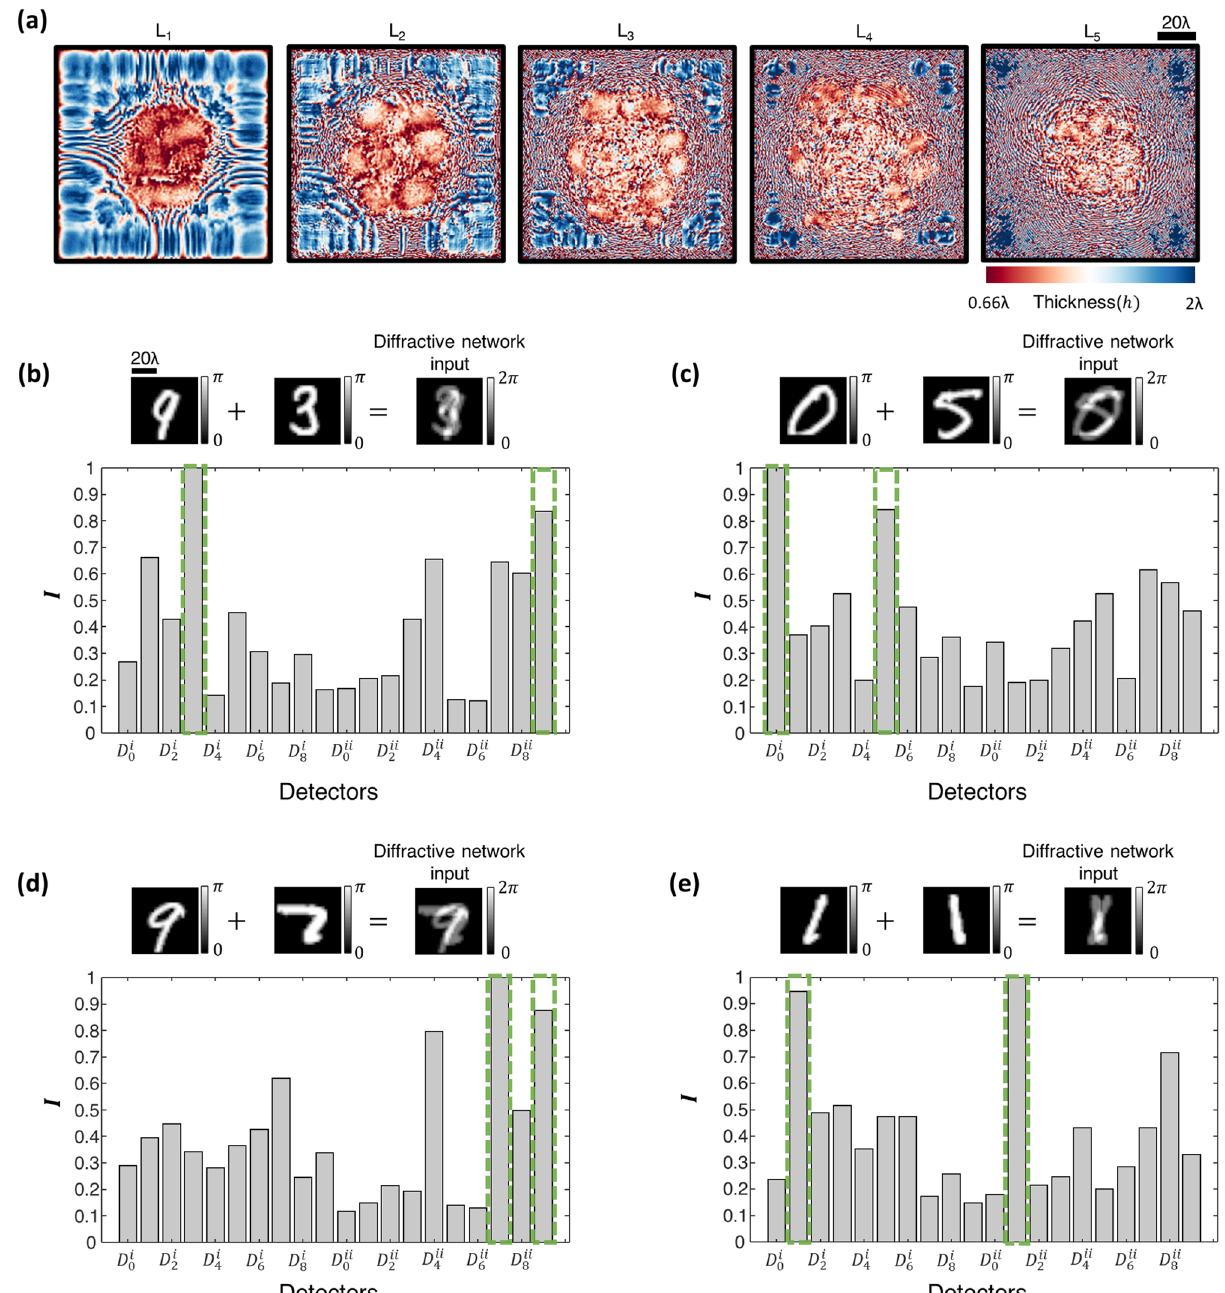
Figure 2. All-optical classification of spatially-overlapping phase objects using the diffractive optical network D 2 NN-D1, based on the detector layout scheme (D-1) shown in Fig. 1b. ( a ) The thickness profiles of the diffractive layers constituting the diffractive optical network D 2 NN-D1 at the end of its training. This network achieves 82.70% blind inference accuracy on the test image set T 2 . ( b – e ) Top: Individual phase objects (examples) and the resulting input phase distribution created by their spatial overlap at the input field-of-view. Bottom: The normalized optical signals, I , synthesized by D 2 NN-D1 at its output detectors. The output detectors with the largest 2 signals correctly reveal the classes of the overlapping input phase objects (indicated with the green rectangular